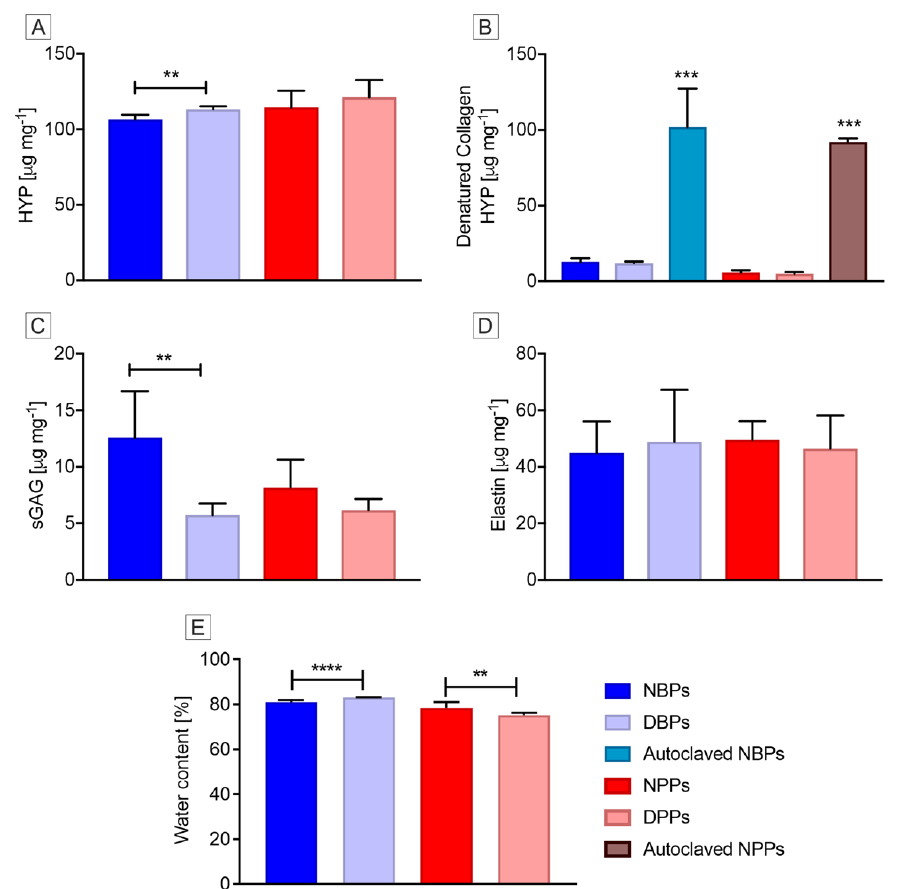
Figure 5. Quantitative biochemical profile of bovine and porcine pericardia before and after TRICOL decellularization. ( A ) Hydroxyproline (HYP) content. Estimated amount of HYP appeared superior in decellularized bovine tissues especially. ( B ) Denatured HYP. No denaturation was observed after decellularization in both species, as opposite to positive controls (autoclaved tissues). ( C ) Sulfated glycosaminoglycans ( sGAGs) content. TRICOL decellularization decreased sGAGs, significantly in bovine pericardium. ( D ) Elastin content. No significant differences were revealed for elastin content. ( E ) Hydration level. Water content modified significantly after decellularization: it increased for bovine pericardium, while decreased for porcine one. Data are presented as mean ± standard deviation (SD). * p <0.05; ** p <0.01; *** p <0.001; **** p < 0.0001. NBP= Native Bovine Pericardium, DBP= Decellularized Bovine Pericardium, NPP= Native Porcine Pericardium, and DPP= Decellularized Porcine Pericardium.